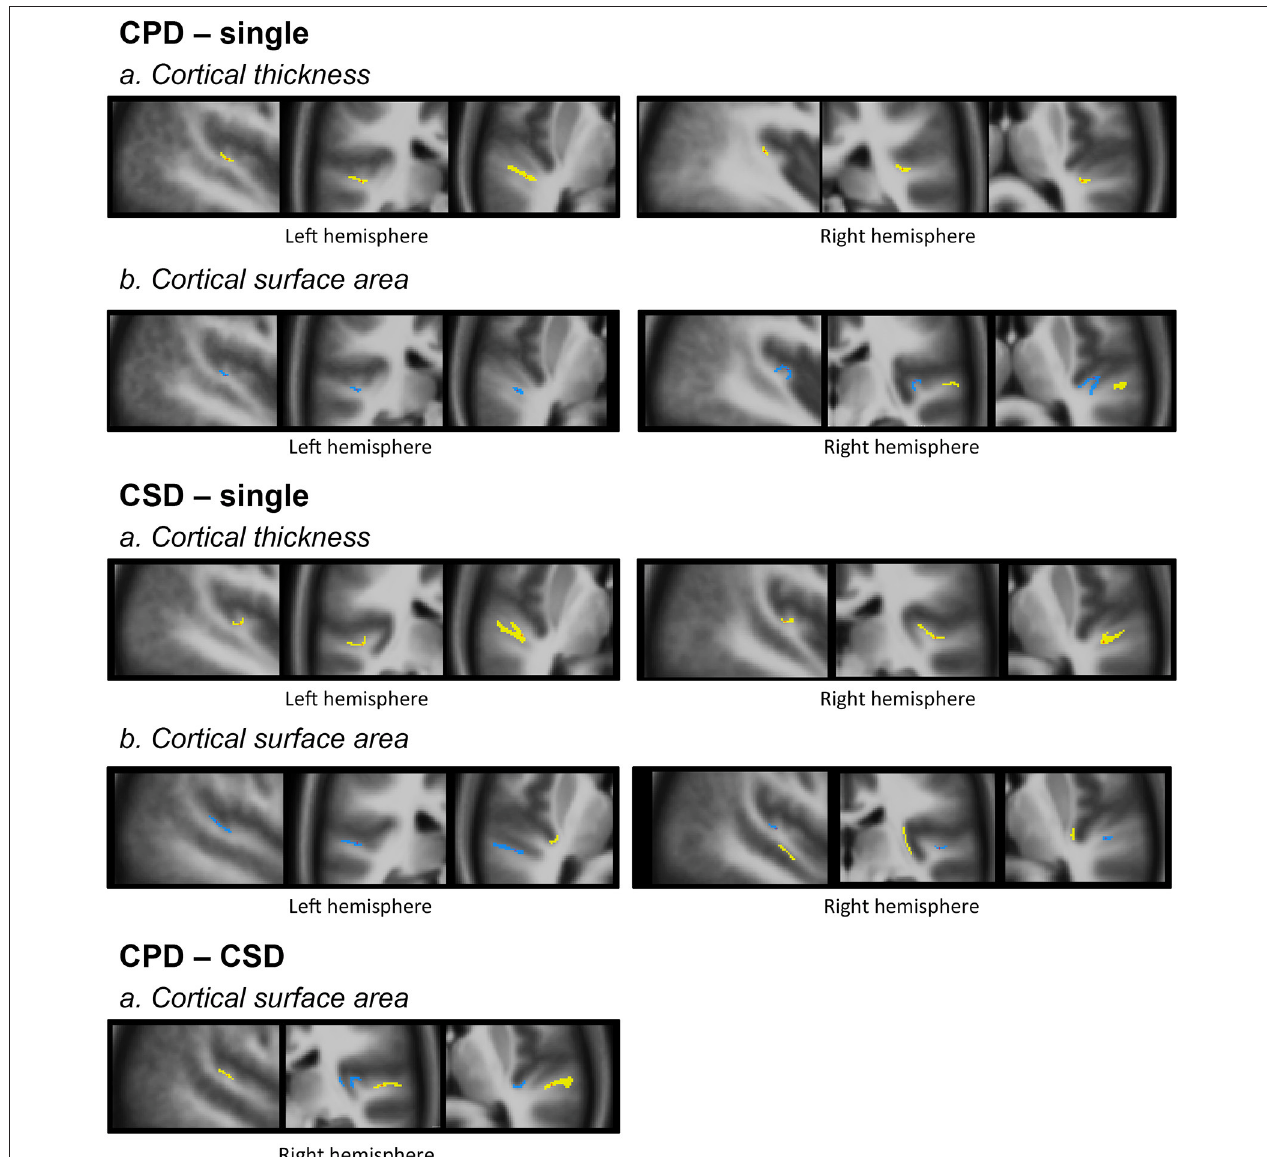
FIGURE 4 | Morphology and relationships between variations in CT and CSA. Projection of the SBM results on the volumetric means of each group of individuals defined according to their gyrification pattern. Results of “CPD-single” and “CPD-CSD” contrasts superposed on the mean images of 48 left CPD or 96 CPD for the right side. Results of “CSD-single HG” contrasts superimposed on the mean image of 98 CSD for the left hemisphere or 95 CSD for the right hemisphere. The yellow scale corresponds to increased values, and the blue scale to decreased values. From left to right a sagittal, a coronal, and an axial slice are presented passing through the significant